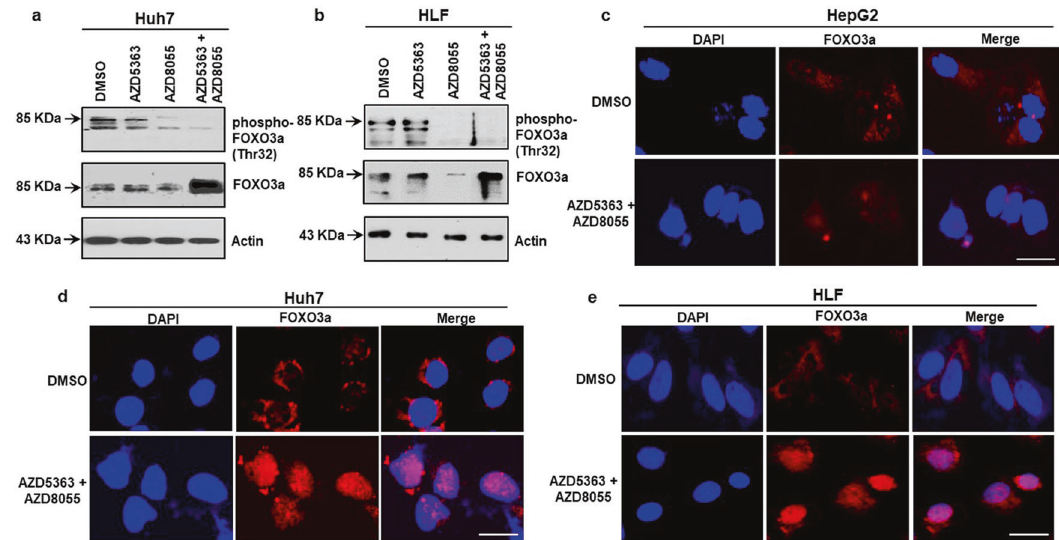
Fig. 4 Combine inhibitor treatment promotes FOXO3a activation. Western blot analysis was performed in p53 mutated HCC cells after treatment with individual or a combination of 5 µM AZD5363 and 100 nM AZD8055 inhibitors for 48 h. The expression of phospho-FOXO3a (Thr32) and total FOXO3a in Huh7 ( a ) and HLF ( b ) are shown. Expression level of actin in each lane was considered for comparison of protein load and illustrated by representative blots shown at the bottom. Subcellular localization FOXO3a was analyzed by confocal microscopy after combine treatment of HepG2 ( c ), Huh7 ( d ), and HLF ( e ) with 5 µM AZD5363 and 100 nM AZD8055 for 48 h. Staining of FOXO3a stained as red and nucleus as blue (DAPI) are shown at 10 µm scale bar.